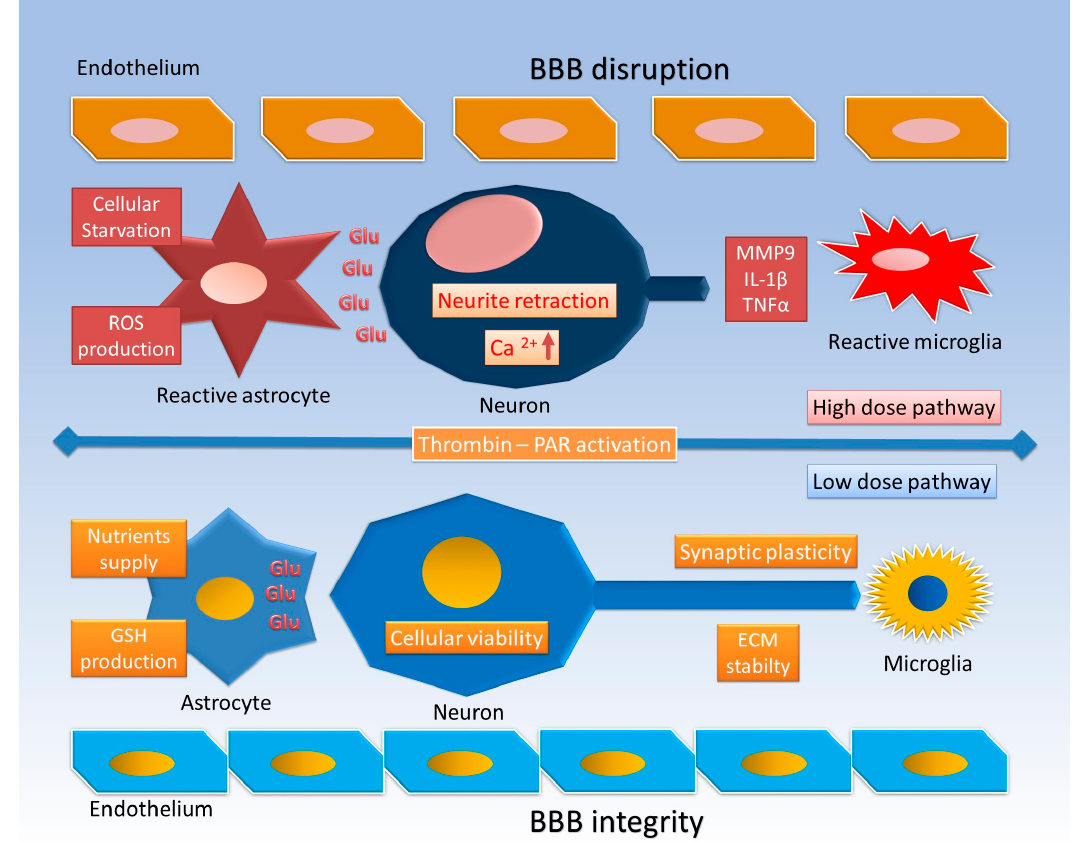
Figure 1. Thrombin effects at low and high doses. At low doses, astrocytes lose their star morphology maintain their fundamental role in nutrient supply, glutamate (Glu) sinking, and glutathione (GSH) production, thus promoting cell survival and synaptic plasticity; the blood–brain barrier (BBB) and extracellular matrix (ECM) both maintain their stability. At high doses, reactive astrocytes and microglia proliferate, lose their Glu regulatory function, and produce reactive oxygen species (ROS) and inflammatory cytokines (interleukin 1 β (IL-1 β ), tumor necrosis factor α (TNF α )); neurons suffer neurite retraction, intracellular Ca 2+ upregulation, and finally cell death, while the BBB is damaged and the ECM is digested by matrix metalloproteinases (MMPs).